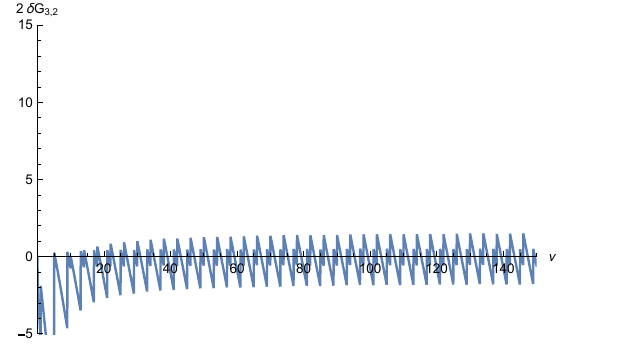
Figure 7 . Error estimate for the second moment. We consider the di(cid:11)erence between the l.h.s. and the smooth terms in the r.h.s. of (6.12). We also multiply it by a factor (cid:23) 1 = 2 . The result is a highly oscillating function of approximately constant amplitude. This is consistent with the error estimate in